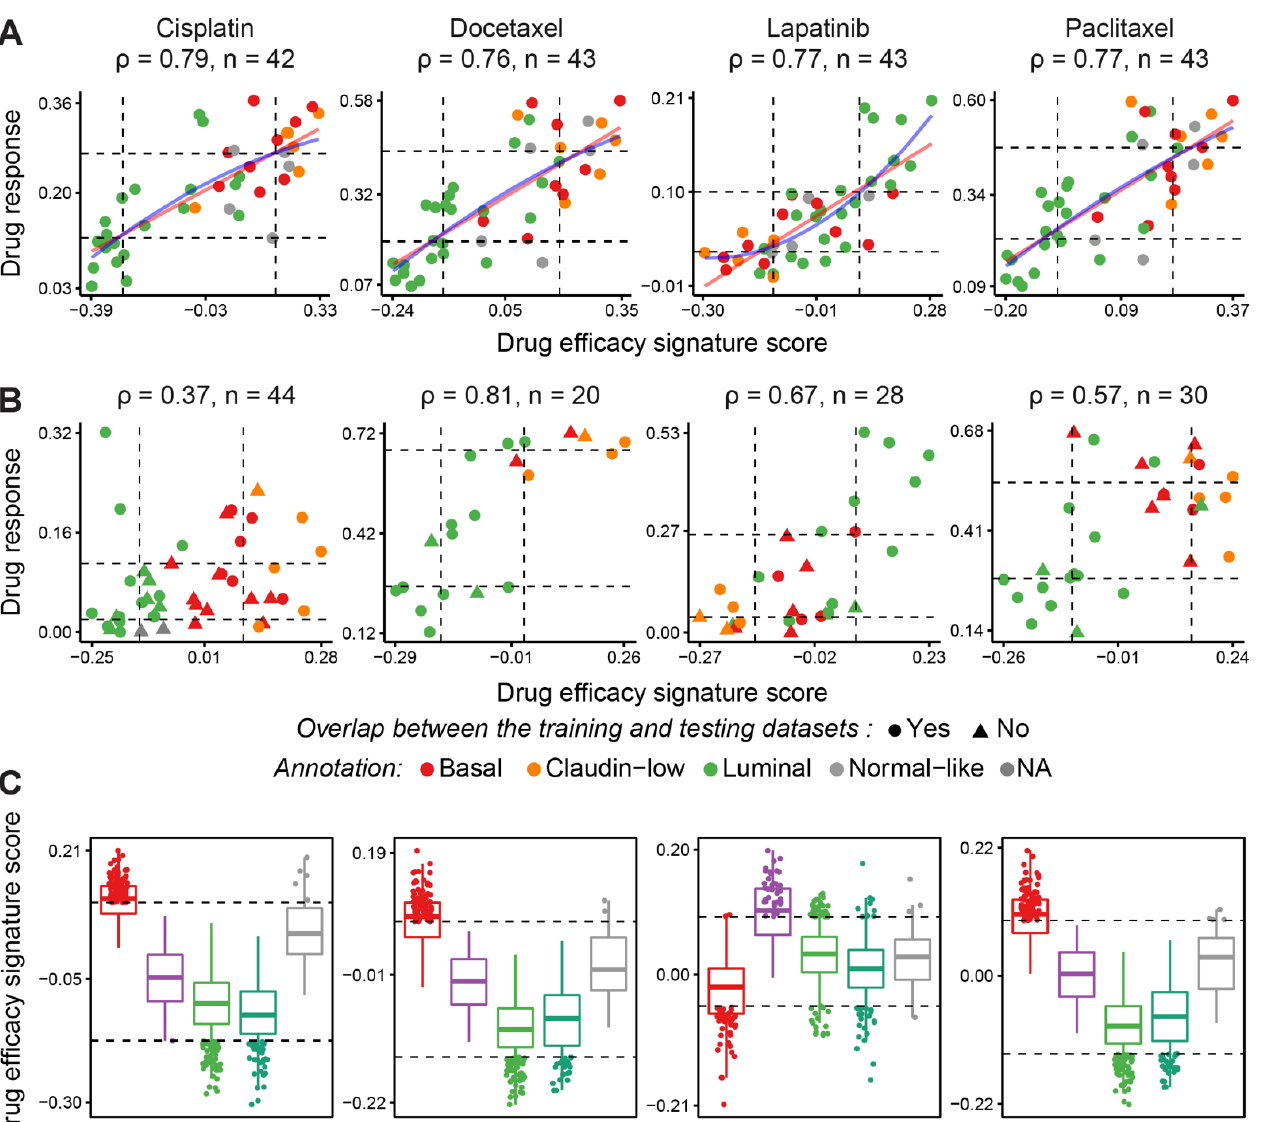
Figure 1. Consistent patterns obtained from drug efficacy signatures across training and test sets for standard of care. Associations between drug efficacy signature scores and drug response (AUC) for four selected drugs in the training data (in ( A ), Gray data), and test sets (in ( B ), from left to right: CCLE for lapatinib, CTRPv2 for docetaxel and paclitaxel, and GDSC1000 for cisplatin). In panel ( C ), TCGA breast cancer samples were scored against these four drug efficacy signatures and stratified by subtypes. Dashed lines in ( A , B ) represent the first and third quartiles while in ( C ), they separate the jittered samples with 10%-tile and 90%-tile drug efficacy signature scores. Note that in each of the test sets in B, cell lines are represented with different shapes (triangle and circle) according to their overlap status with the training set.